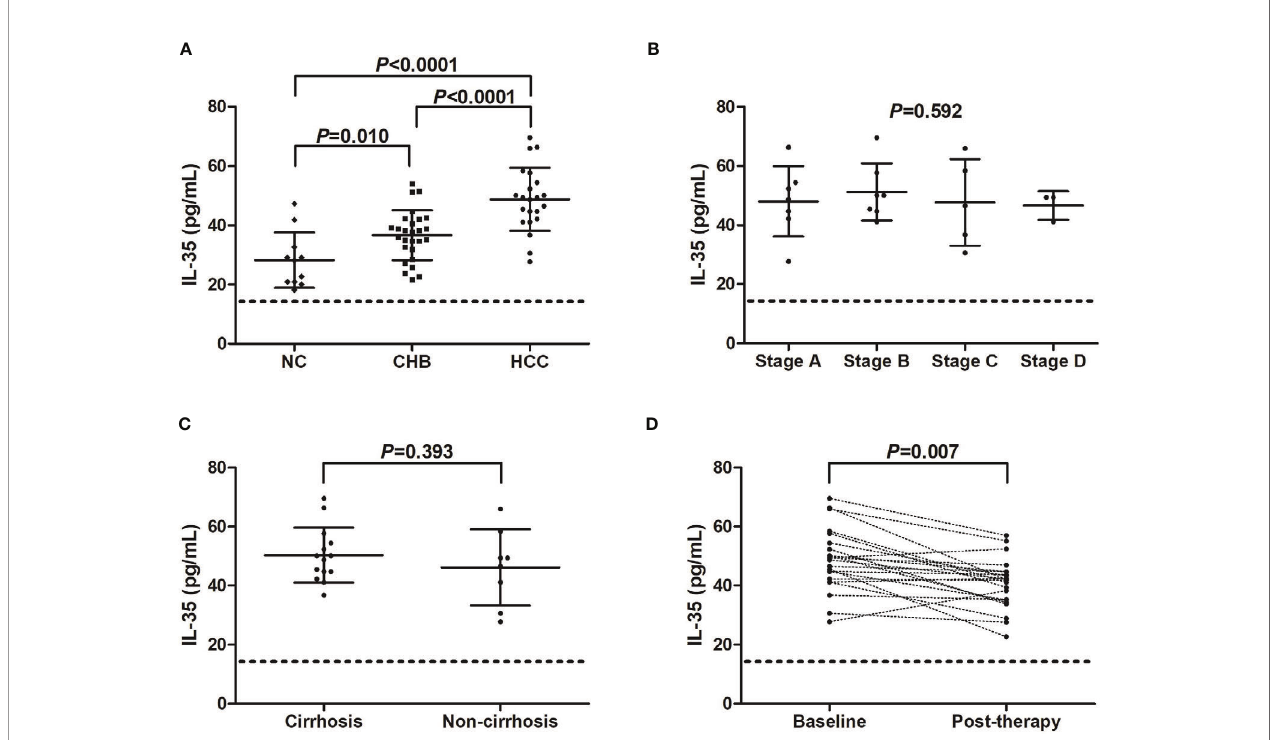
FIGURE 1 | IL-35 level in hepatitis B-related hepatocellular carcinoma (HCC). (A) Serum IL-35 concentration was measured by ELISA in normal controls (NC, n =11), chronic hepatitis B (CHB) patients ( n =27), and hepatitis B-related HCC patients ( n =22). Signi fi cance was assessed using one-way ANOVA and SNK- q test. (B) Serum IL-35 level was compared among hepatitis B-related HCC patients in BCLC stage A ( n =7), stage B ( n =7), stage C ( n =5), and stage D ( n =3). Signi fi cance was assessed using one-way ANOVA. (C) Serum IL-35 was also compared between hepatitis B-related HCC patients with cirrhosis ( n =14) and without cirrhosis ( n =8). Signi fi cance was assessed using Student t test. (D) Serum IL-35 was also measured in hepatitis B-related HCC patients who underwent hepatic carcinectomy (n=13) or TACE ( n =9), and was compared between baseline and 2 months post therapy. The dotted line presented lower detection limit for IL-35 (15.6 pg/mL). Signi fi cance was assessed using paired t